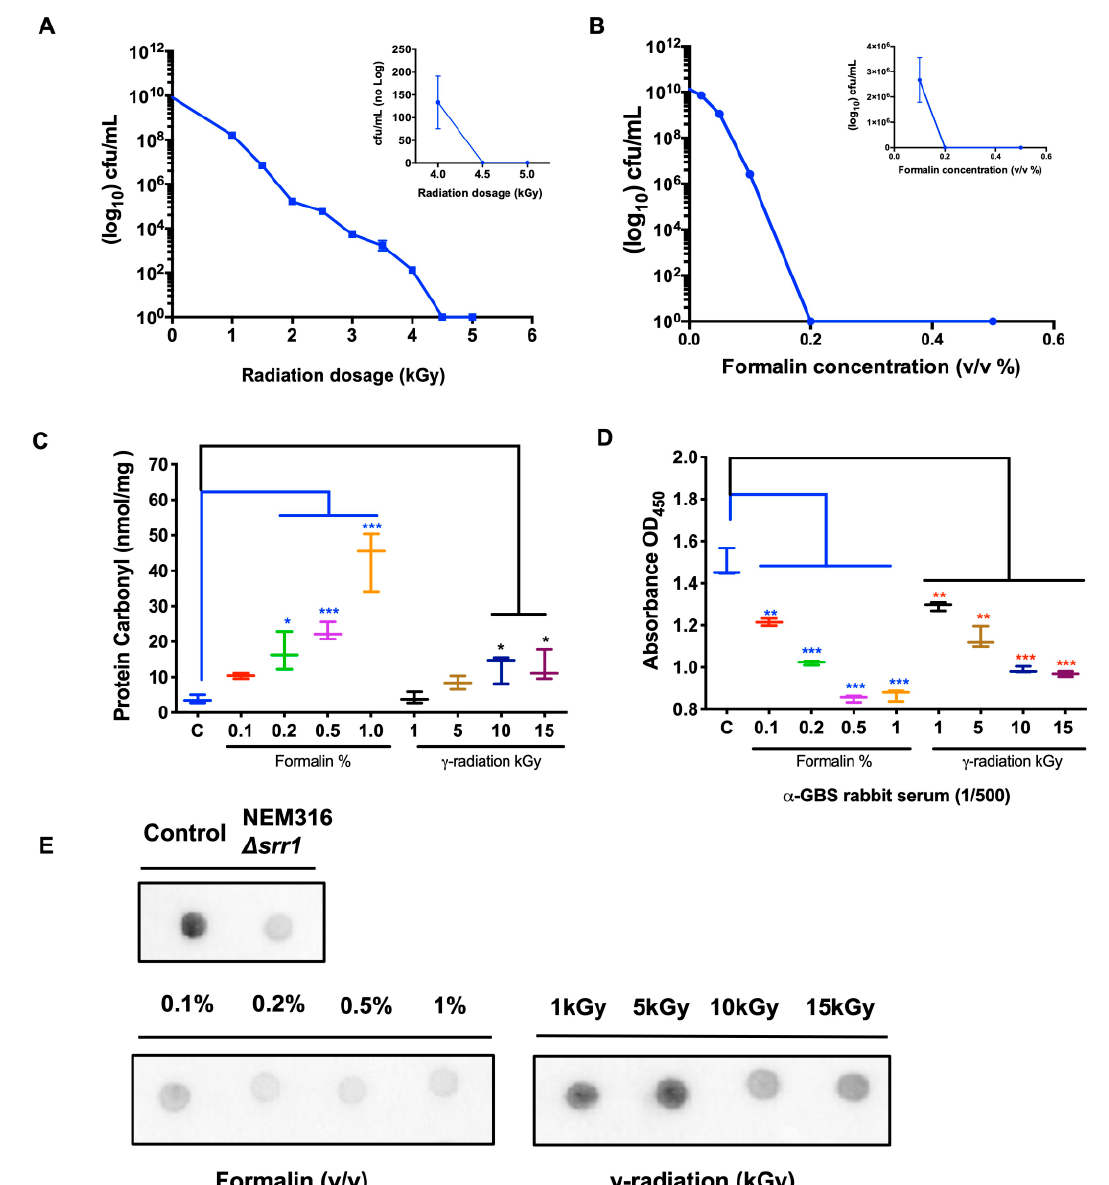
Figure 1. Reduction of the viability of Group B streptococcus treated with gamma-radiation or for- malin. Clinical non-capsule GBS isolate NSP14-358 was exposed to various doses of ( A ) gamma radiation or concentrations of ( B ) formalin in PBS for 2 h at 37 °C. Bacterial viability was determined by counting CFUs on blood agar plates. The aliquots of bacteria grown in the exponential phase were treated with various concentrations of formaldehyde or doses of gamma radiation; the non- treated was GBS used as control. ( C ) The levels of protein carbonyl (nmol/mg) in inactivated GBS lysates were used to quantify the damage to protein epitopes according to the commercial kit. ( D ) The antibody-binding affinities of inactivated GBS were assessed through ELISA using diluted rab- bit anti-GBS serum (1/500 dilution). ( E ) The binding with surface SRRN2N3 epitopes of the antibody by inactivated GBS samples was tested via a dot plot. All data are expressed as the mean ± standard deviation of triplicate samples or three independent experiments, and p-values were determined by performing an unpaired t test. *** Stands for p < 0.001, ** stands for p < 0.01, and * stands for p < 0.05 and NS for not significant.